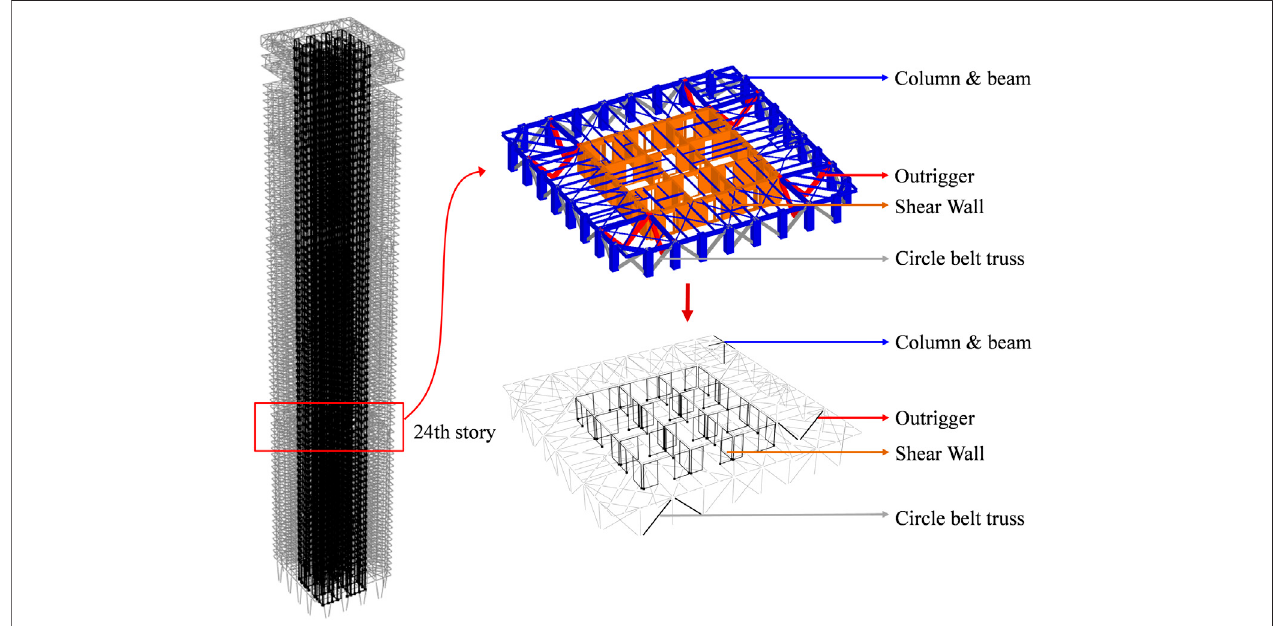
FIGURE 4 | The fi nite element model of the super-tall building.